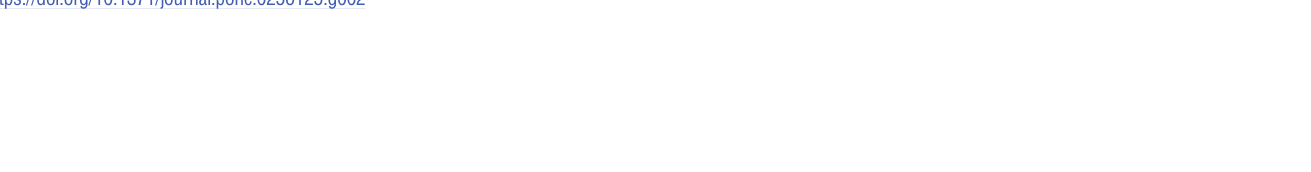
PLOS ONE | https://doi.org/10.1371/journal.pone.0256125 August 25,